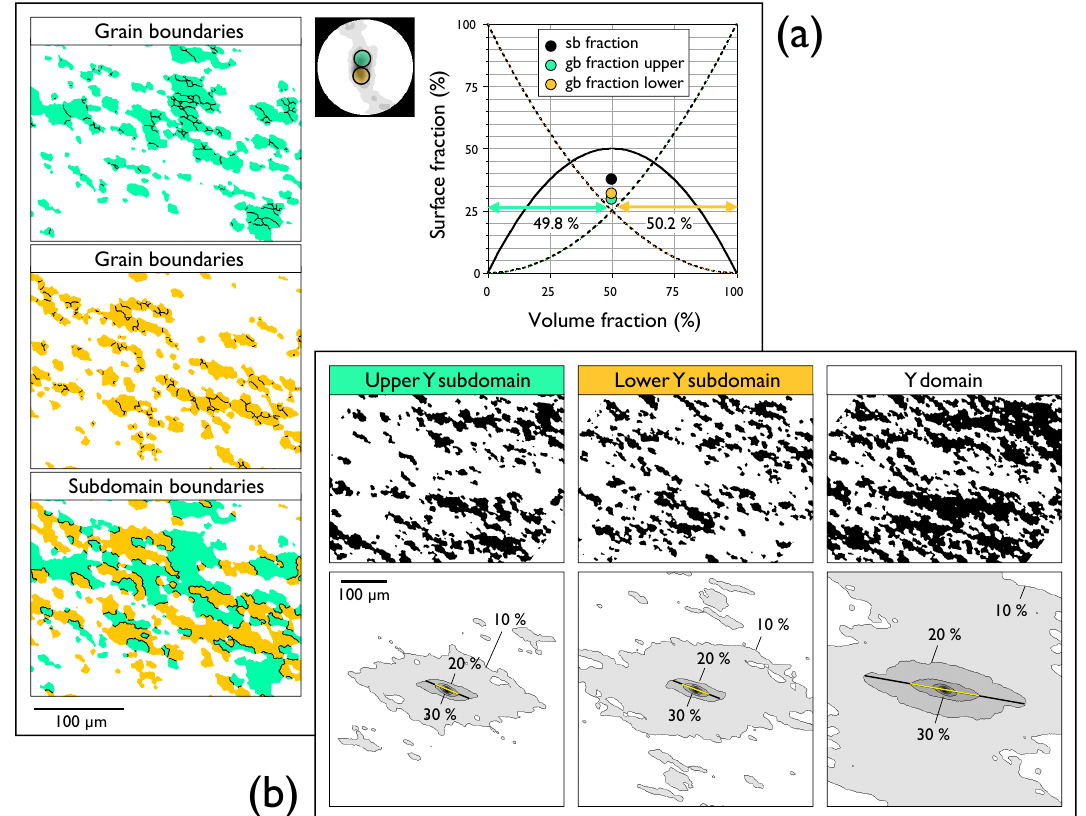
Figure 11. Spatial distribution and cluster size of Y subdomains. Results are shown for sample w935 of regime 3. (a) Spatial analysis to determine if the spatial distribution of subdomains is random, clustered, or ordered (anti-clustered). Maps of subdomains with grain and subdomain boundaries are shown: “upper” (green) and “lower” (yellow) refer to the upper and lower maximum of the pole figure shown on the right, and the scale bar below applies to all. Upper right: plot showing fraction of subdomain boundary (sb) and grain boundary (gb) vs. volume fraction of the subdomains (upper:lower = 49.8:50.2%). Solid and stippled lines are the expected surface fractions for the random case. Fraction sb below and fractions gb above the expected values indicate significant clustering. (b) Autocorrelation analysis of domain and subdomains: thresholded maps with autocorrelation function (ACF) below. Long and short diameters of contours in ACF reflect size and shape of clusters in domain and subdomain maps. Scale bar applies both to ACFs and maps. Three contour levels are indicated as a percentage of ACFmax. Superposed yellow lines indicate long diameter and orientation of 30% contour; black lines are extrapolations to 20% contour (see